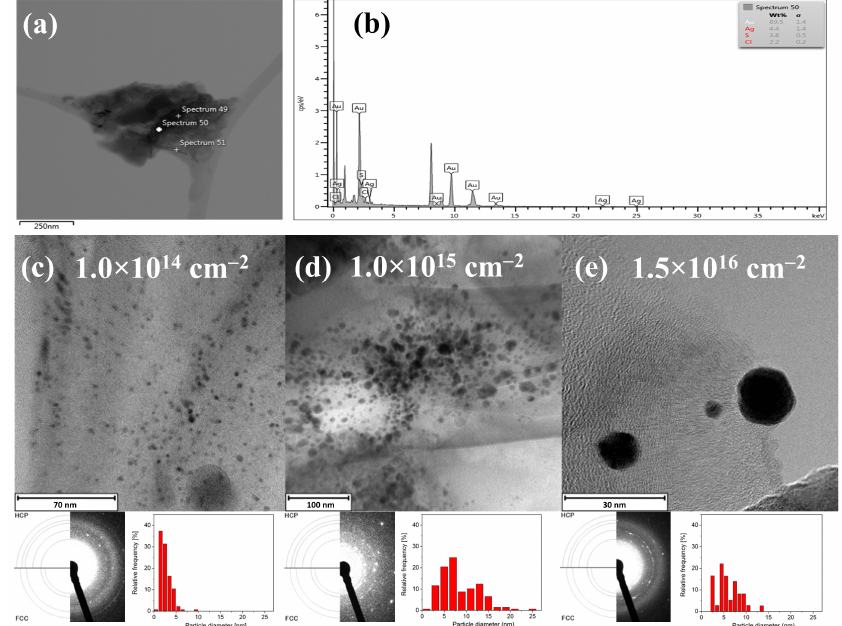
Figure 5. TEM images and EDS analyses of created Au nanoparticles—( a ) Au nanoparticles (black color) placed on the Cu grid; ( b ) EDS elemental analyses at the point marked as fifty.